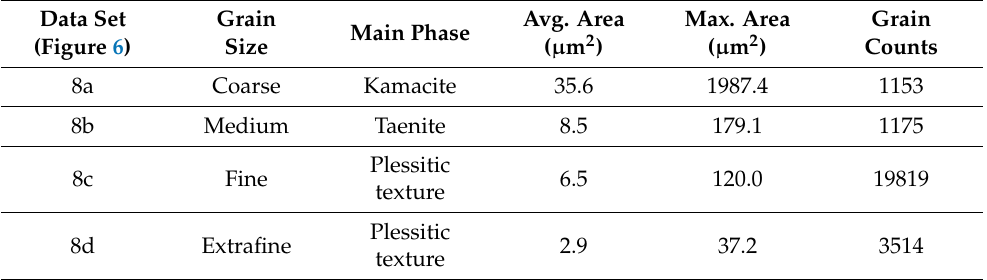
Table 2. Grain size distribution calculated for the four areas of the Oglat Sidi Ali meteorite as distinguished in Figure 6.